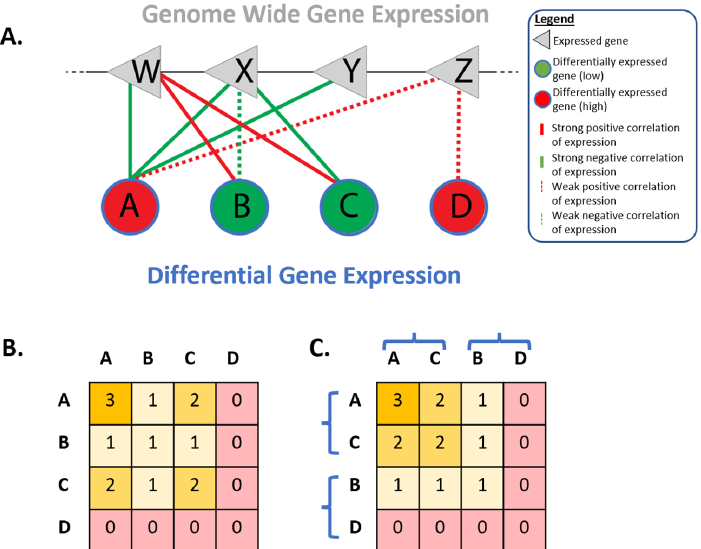
Figure 1. Generating and summarising a hypernetwork model of co-correlated gene expression as a causal model. ( A ). A bipartite network model of correlated gene expression between differentially expressed genes (circles) and the rest of the expressed genes in the genome (triangles). Strong correlations are defined as by the upper and lower standard deviations of the distribution of correlation r-values. ( B ). The number of shared strong correlations between each differentially expressed gene and genes in the genome is calculated and expressed in a square matrix form (symmetrical)—this is the adjacency matrix of the hypernetwork. ( C ). Genes with high numbers of shared correlations are identified by clustering using the Euclidean metric.